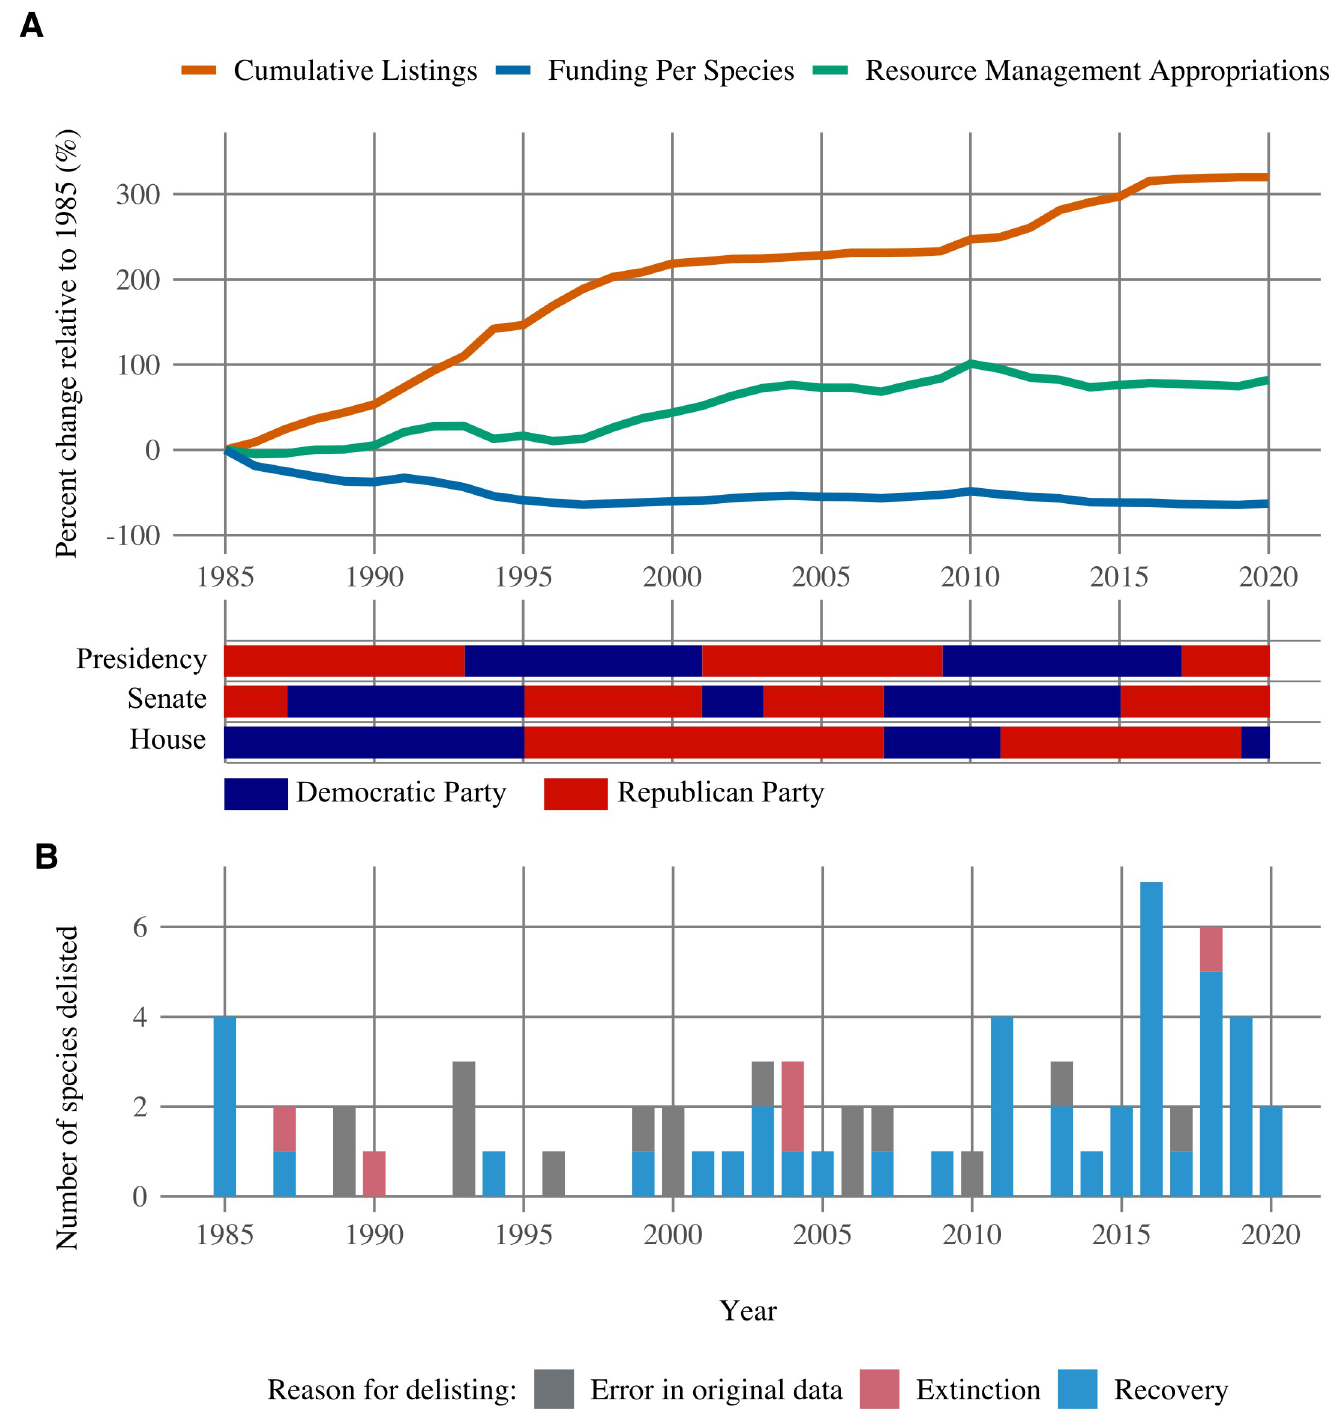
Fig 2. Trends in number of species protected under the ESA and funding for species management, 1985–2020. (A) Change in cumulative number of ESA listings compared to change in Resource Management Appropriations. The lower timeline illustrates political control of the Presidency and, by a majority, each house of Congress. (B) Number of species delisted for various